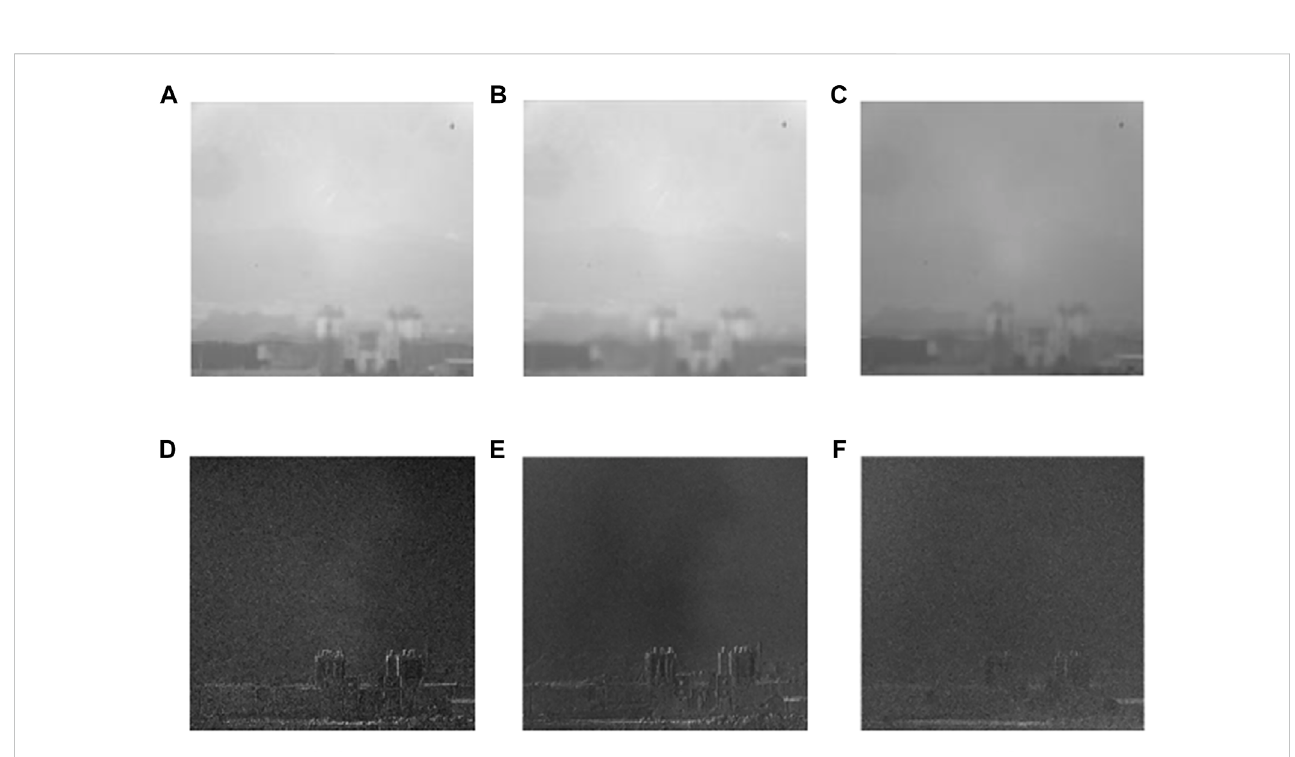
FIGURE 9 Intensity and Polarization images of three wavelengths (A) 670 nm Intensity image (B) 530 nm Intensity image (C) 450 nm Intensity image. (D) 670 nm Polarization image (E) 530 nm Polarization image (F) 450 nm Polarization image.